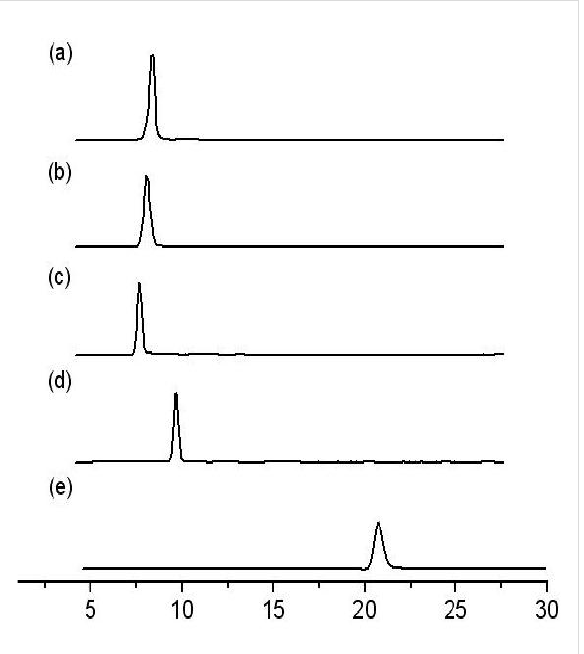
Figure 1: Reversed-phase HPLC analysis. Conditions: C 18 -column 8 mm x 10 cm, mobile phase 6:1 methanol/water (flow rate 0.7 mL/ minute), UV-Vis detection at 206 nm. All the triterpenic acid samples were injected after dissolving in methanol/acetic acid mixture to obtain a sharp peak. HPLC profiles: a: t R [arjunolic acid ( 1 )] = 8.3 min, b: t R (mixture of the triterpenic acids 1 and 2 ) = 8.7 min, c: t R [asiatic acid ( 2 )] = 9.0 min), d: t R (arjuna-bromolactone 3 ) = 10.0 min), e: t R [methyl asiatate ( 4 )] = 20.7